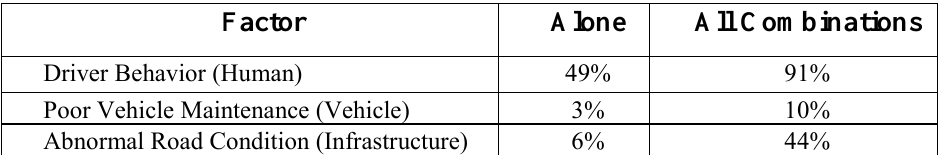
Table 1. Figure.3 Influence of each factor in the occurrence of accidents